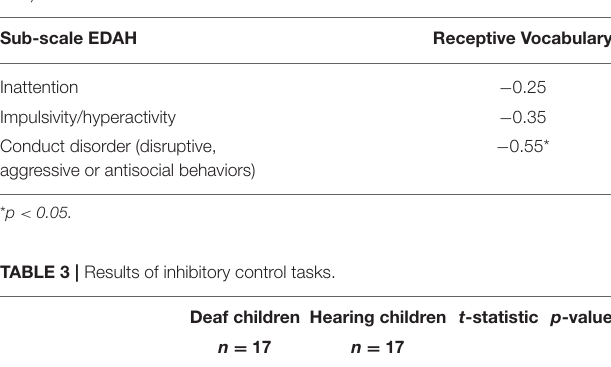
TABLE 2 | Correlations coefficients between the centile scores obtained from the three sub-scales of the EDAH and the scores on receptive vocabulary (Spearman Rho).